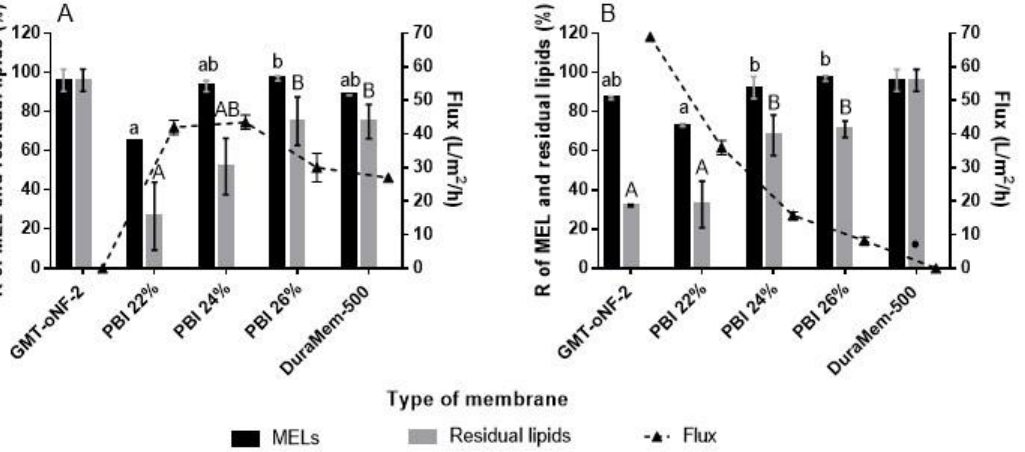
Figure 2. The rejection coefficient for MELs and residual lipids, and the solvent flux for each OSN membrane: PBI 22, 24 and 26%; GMT-oNF-2 (Borsig) and DuraMem-500 (Evonik) using MeOH ( A ) and EtOAc ( B ). Dots refer to filtrations that did not occur, since no solution has permeated. Different lowercase and uppercase letters in each colunm represent significant variations in MELs and residual lipids rejections, respectively, for different membranes and the same solvent. Results for membranes highlighted in different letters have a p -value lower than 0.05.